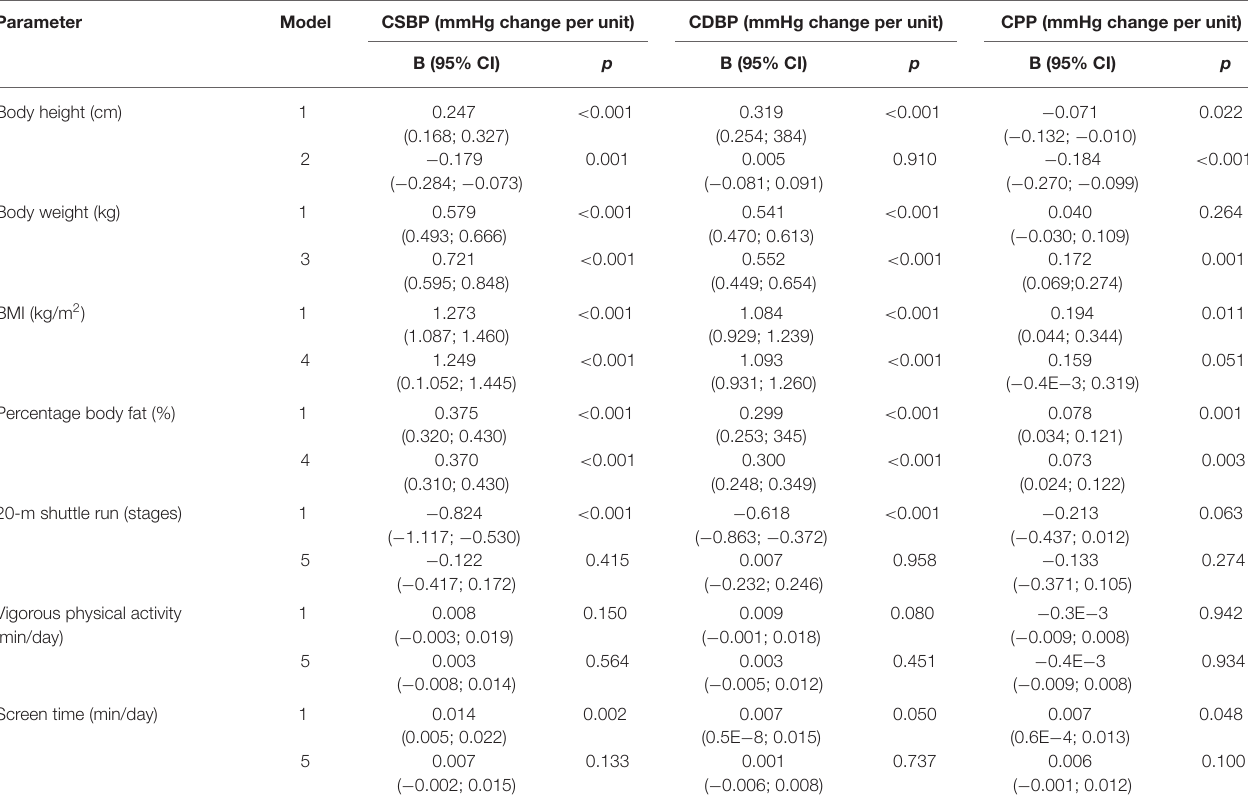
TABLE 3 | Regression analysis for the association of body composition, physical activity, and fitness with central blood pressure and pulse pressure.